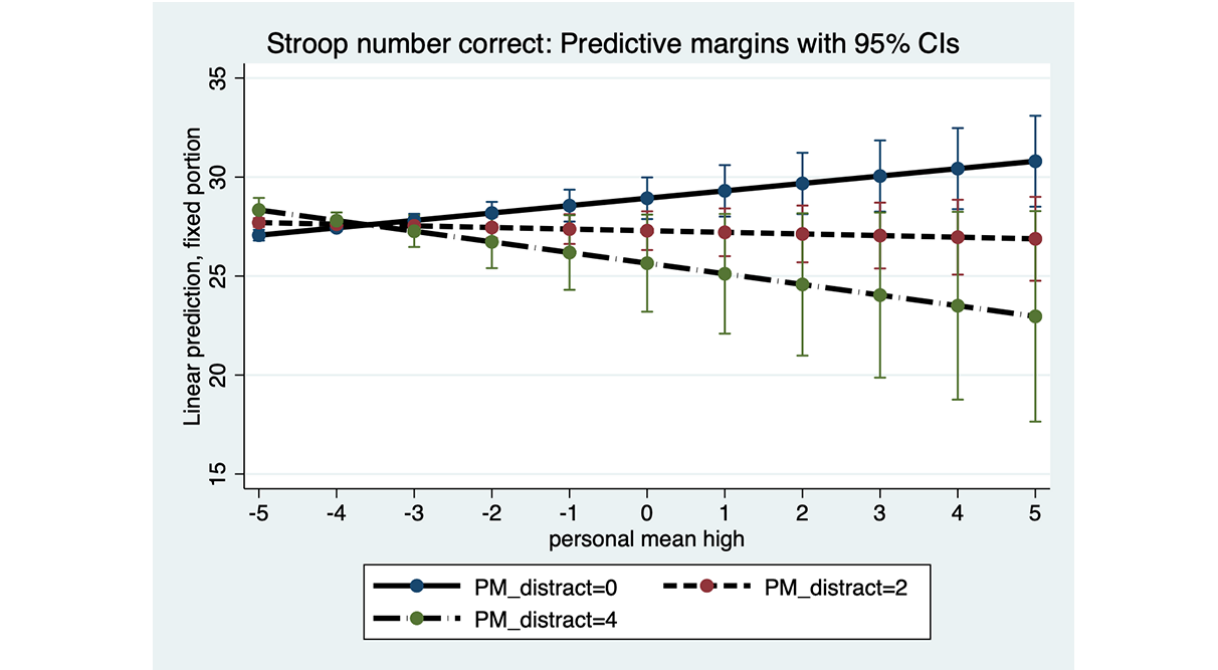
Figure 6. Marijuana Stroop: distraction person mean (PM) as a moderator of the association between subjective high PM and number of correct responses. Distraction PM at low (0), moderate (2) and high levels (4). PM: person mean.